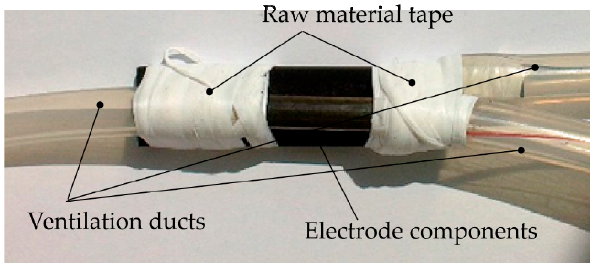
Figure 8. The membrane electrode assembly (MEA) of a single cell of tubular DMFC.